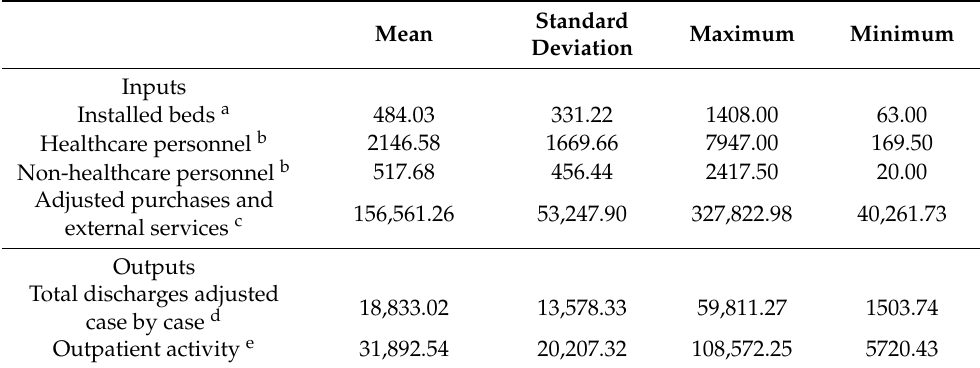
Table 1. Input-Output variables of the Spanish National Health System General Hospitals.